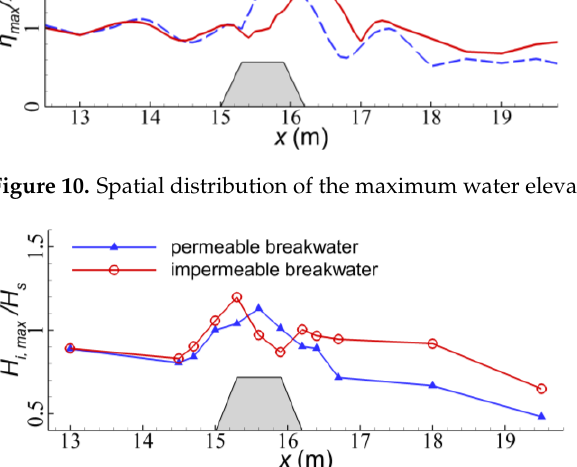
Figure 11. Spatial variations in the maximum local wave height.